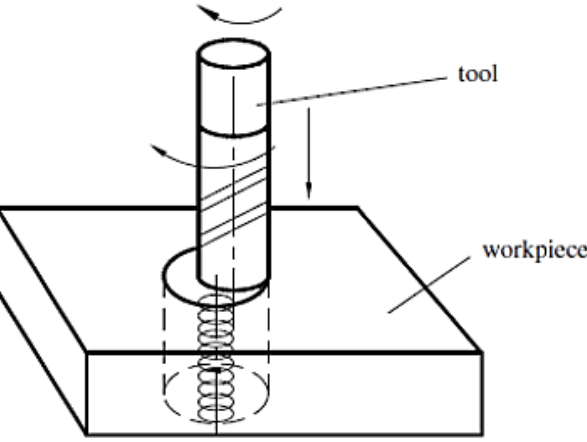
Figure 11. Kinematics of helical milling [121]. Reproduced with permission from Springer.